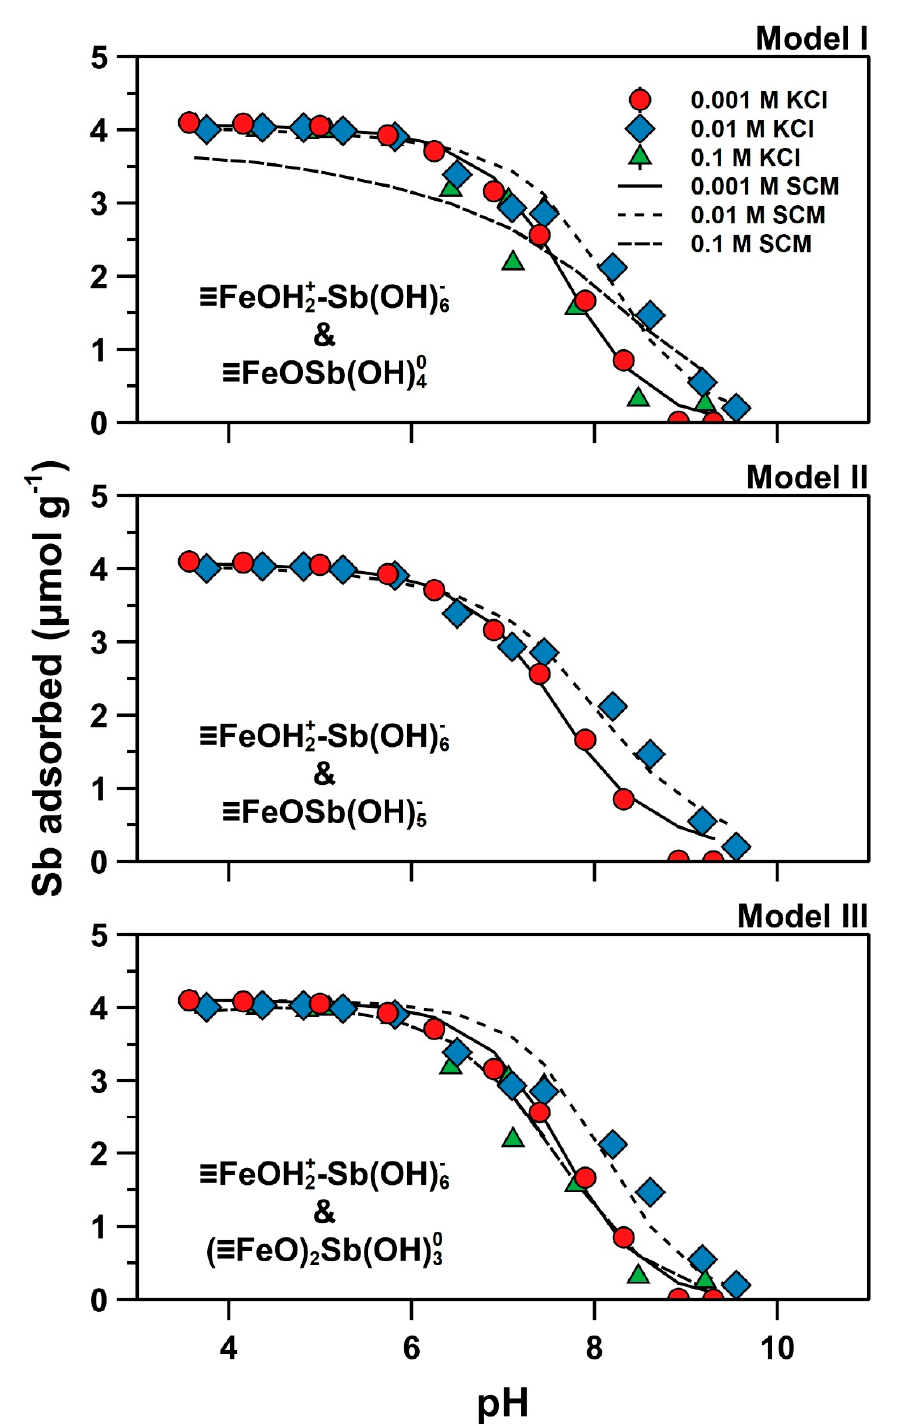
Figure 4. ( A ) (Top) Model 1. The experimental and predicted adsorption of Sb on hematite as a function of pH in 0.001, 0.01, and 0.1 M KCl ionic media. The surface complexation model assumes the formation of inner-sphere [ ≡ FeOSb(OH) 4 ◦ ] and outer-sphere [ ≡ FeOH 2+ − Sb(OH) 6 − ] complexes. ( B ) ( Middle ) Model II. The experimental and predicted adsorption of Sb on hematite as a function of pH in 0.001 and 0.01 M KCl ionic media. The surface complexation model assumes the formation of inner-sphere [ ≡ FeOSb(OH) 5 − ] and outer-sphere [ ≡ FeOH 2 + − Sb(OH) 6 − ] complexes. ( C ) (Bottom) Model III. The experimental and predicted adsorption of Sb on hematite as a function of pH in 0.001 and 0.01 M KCl ionic media. The surface complexation model assumes the formation of bidentate inner-sphere [( ≡ FeO) 2 Sb(OH) 3 ◦ ] and outer-sphere [ ≡ FeOH 2 + − Sb(OH) 6 − ]